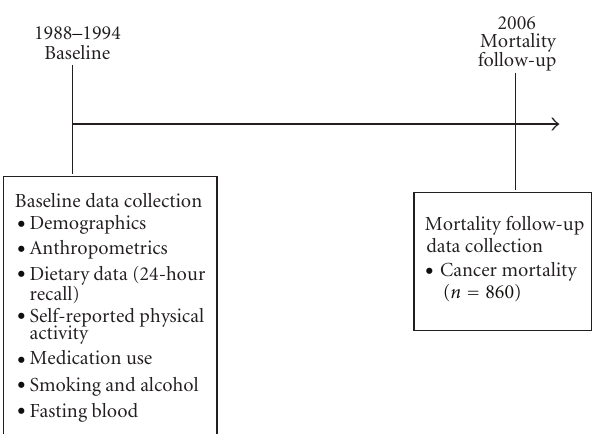
Figure 1: NHANES III data collection